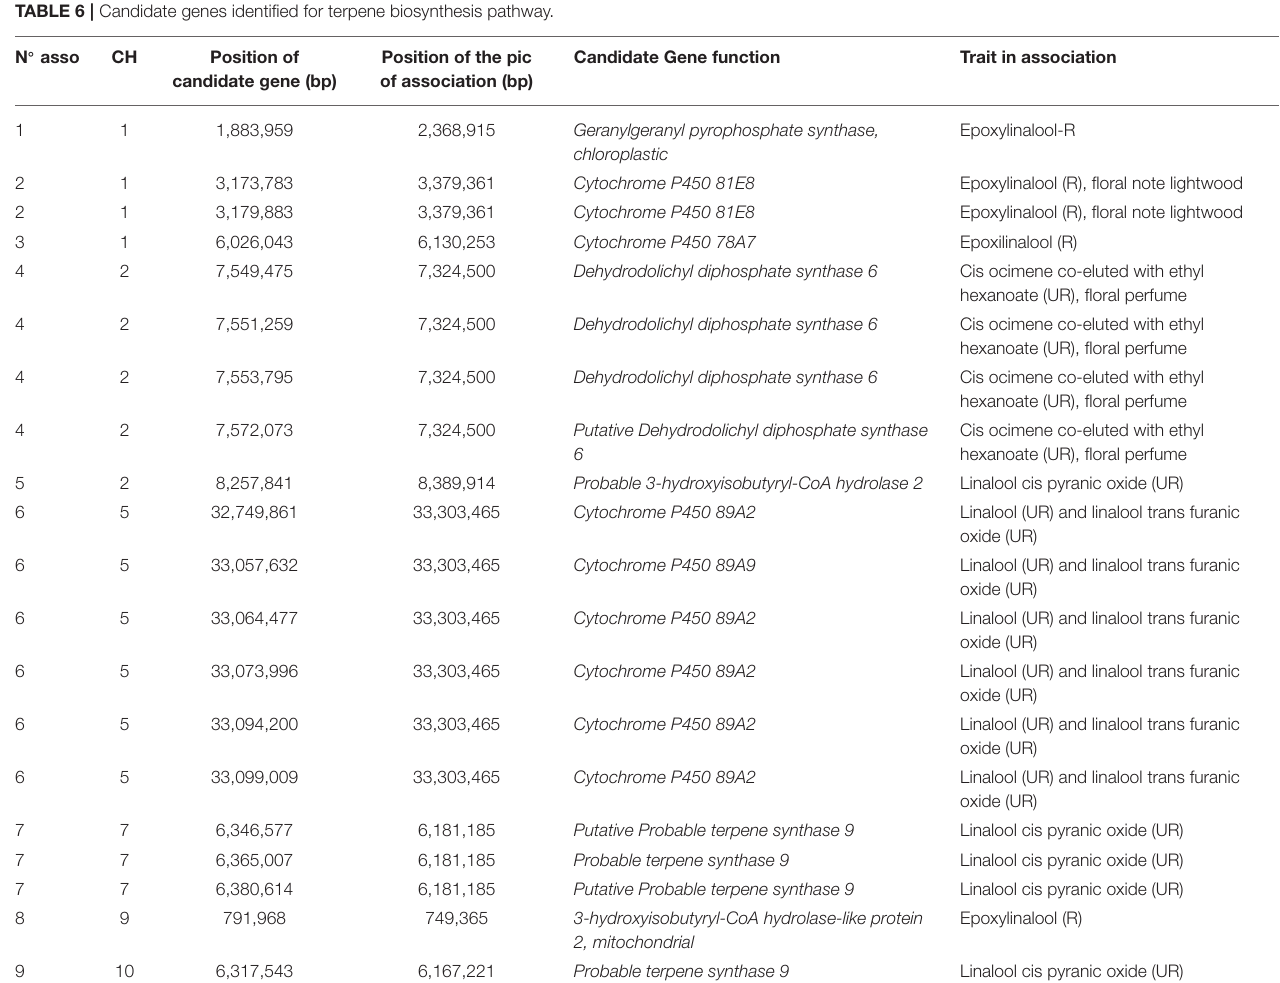
TABLE 6 | Candidate genes identified for terpene biosynthesis